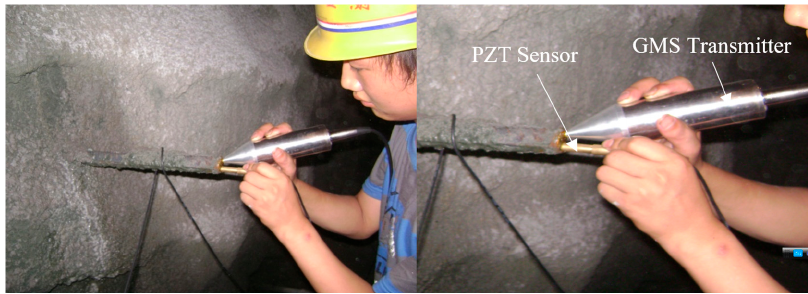
Figure 13. Field tests at Site 2.